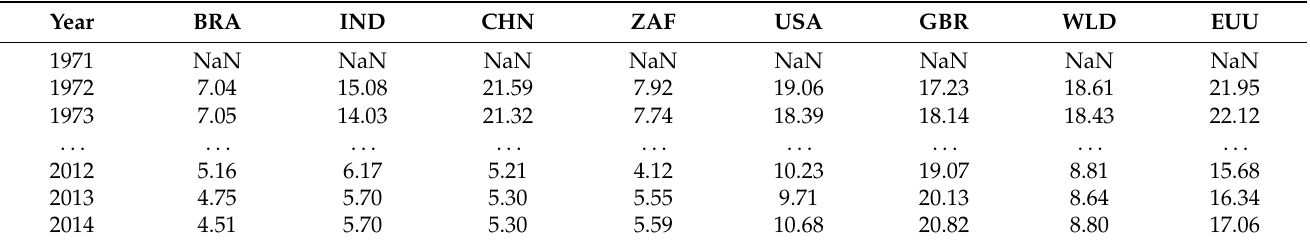
Table 13. Predictions of the naïve model. When compared with Table 1, it can be seen that the data have been shifted one row below, i.e., the values for 1971 in Table 1 are now placed in row 2.